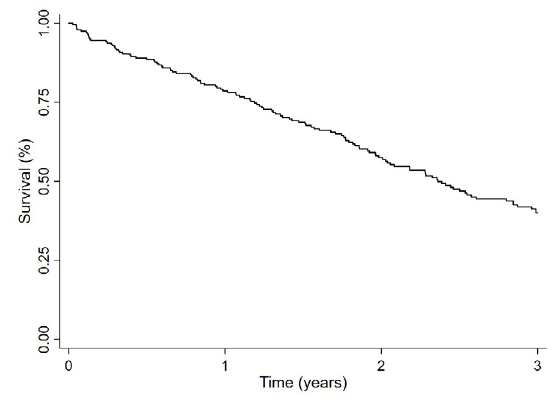
Figure 2. Kaplan-Meier survival curve during the 3 years of